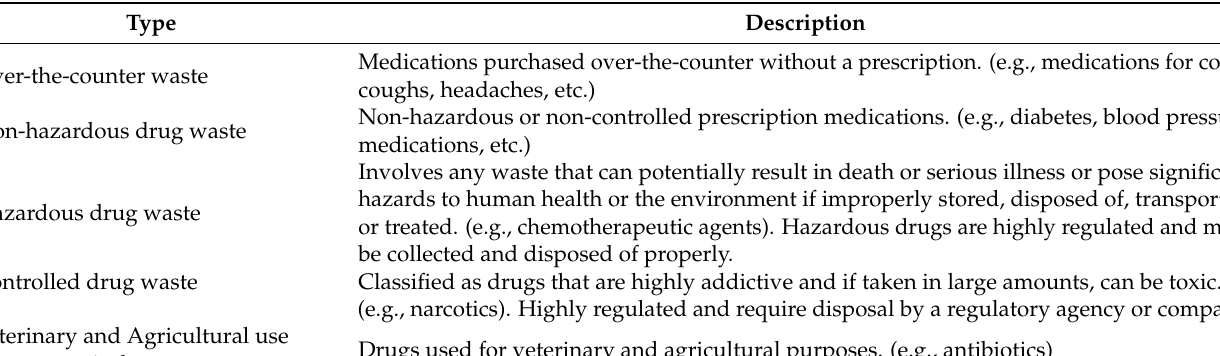
Table 1. Types of pharmaceutical